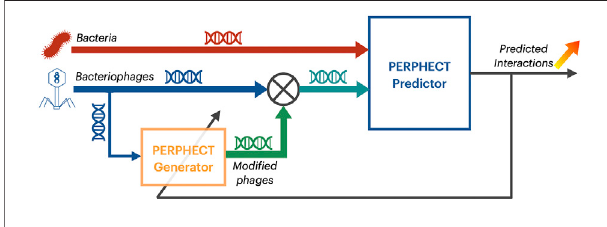
FIGURE 1 | PERPHECT model architecture. PERPHECT architecture is formed of two fundamental components: i) The PERPHECT predictor used to predict potential interactions between bacteria and phages based solely on their genomic information and composed of a multi-branch 1-D CNN and ii) the PERPHECT generator used to modify existing phage genome sequences to improve their predicted host range and composed of LSTMs.